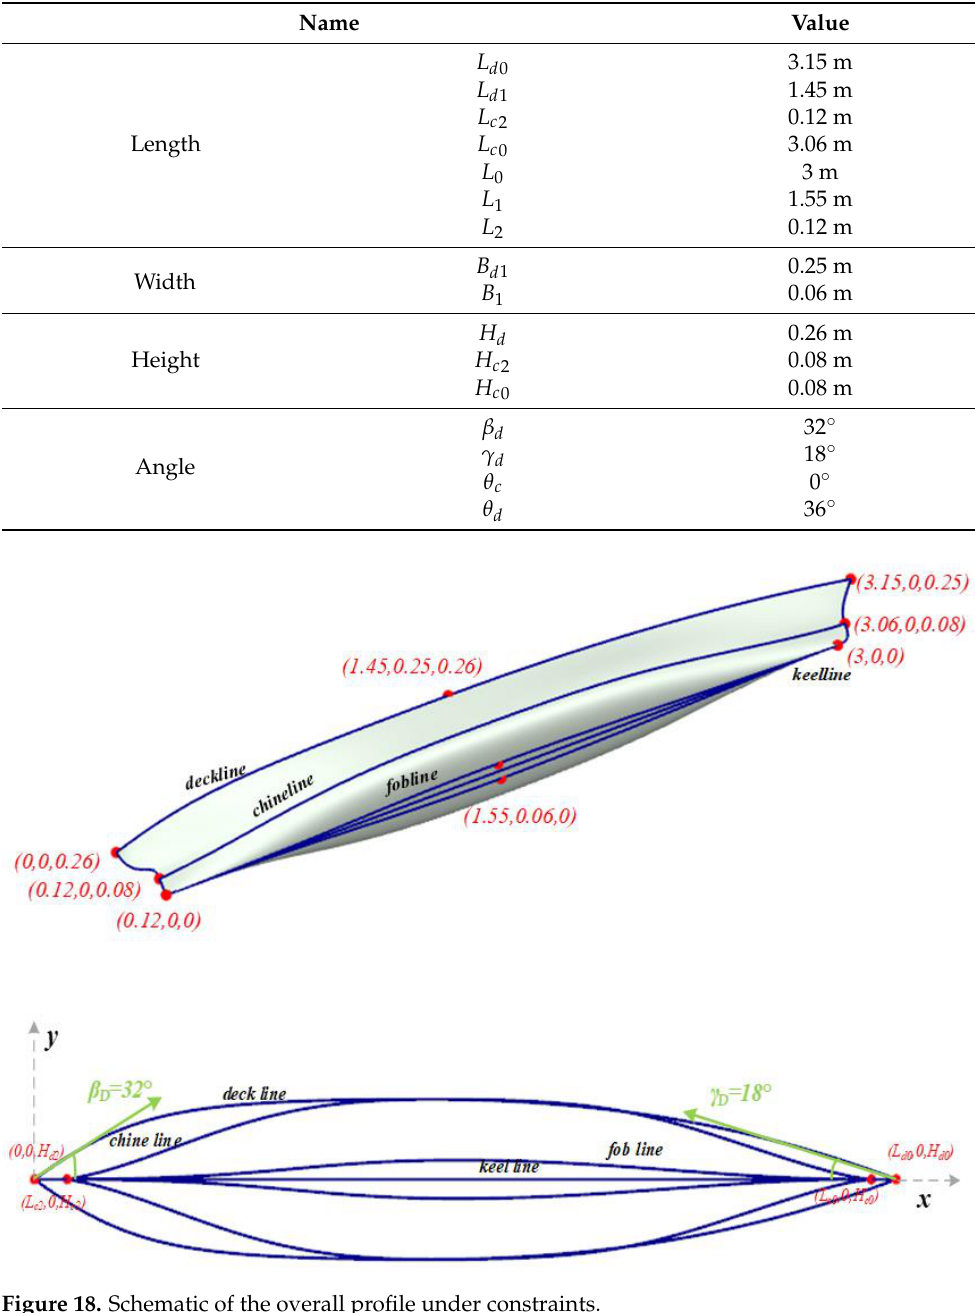
Table 3. Combination of parameters as constraints.